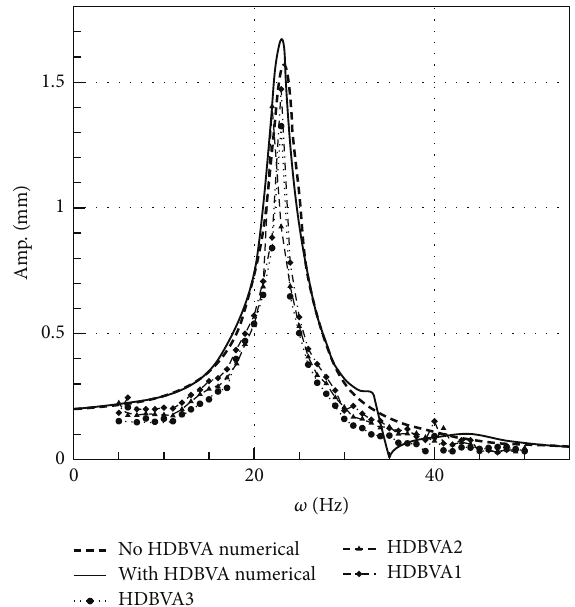
Figure 19: Frequency response of 𝑍 𝑍 DOF of case Figure 10(a), HDBVAs start at the near-force point.